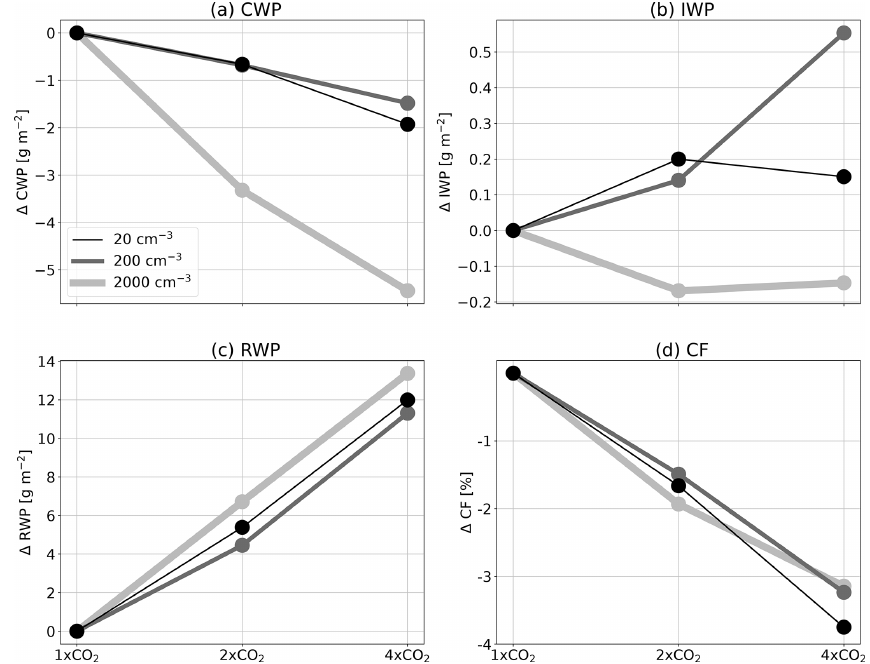
Figure 4. The change in (a) cloud liquid water path (CWP), (b) ice water path (IWP), (c) rainwater path (RWP) and (d) cloud fraction (CF) due to a change in the CO 2 concentration (compared to the 1 × CO 2 case of each aerosol concentration), for the different aerosol concentrations (the different